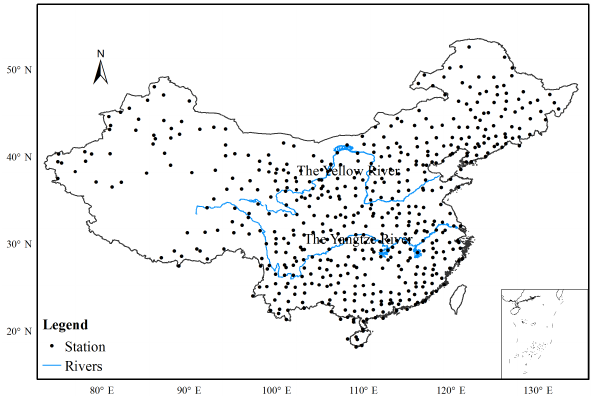
Figure 1. The spatial distribution of precipitation stations used in this